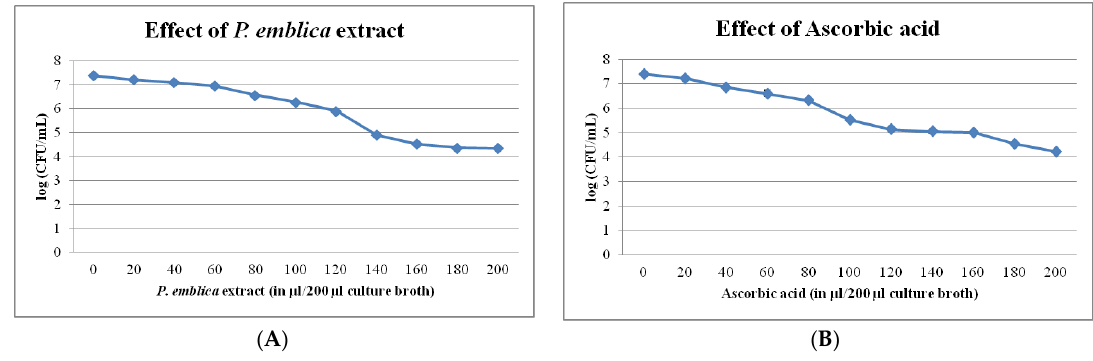
Figure 4. Effect of different concentrations of P. emblica extract ( A ) and ascorbic acid ( B ) on the viability of R. solanacearum NAIMCC-B-01630 cells in log (CFU/mL).